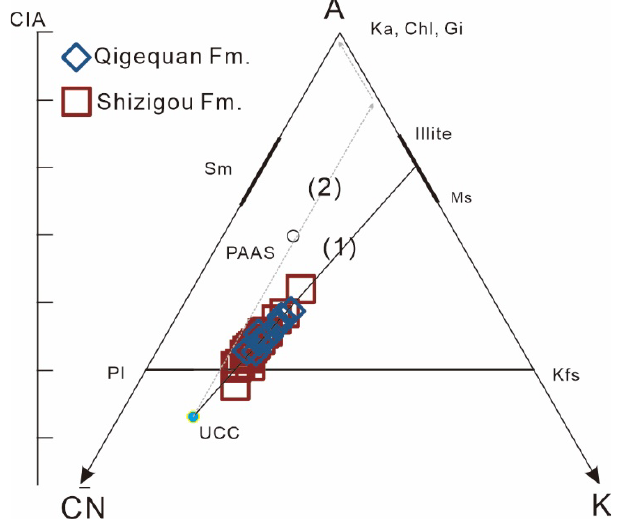
Figure 7. A–CN–K ternary diagrams for rock samples in this study. Abbreviations: Ka—kaolinite; Chl—chlorite; Gi—Gibbsite; Sm—smectite; Mu-muscovite; Pl—plagioclase; Kfs—K-feldspar.